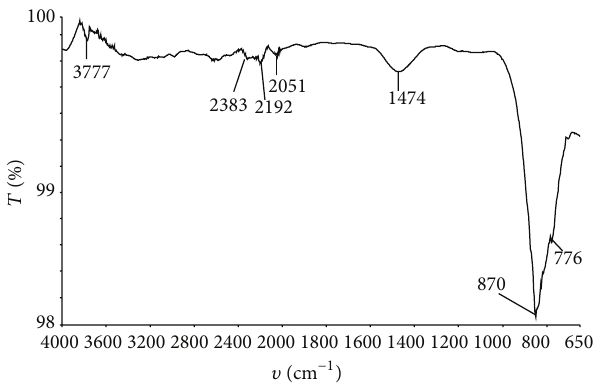
Figure 2: The FTIR spectrum of the LF slag.